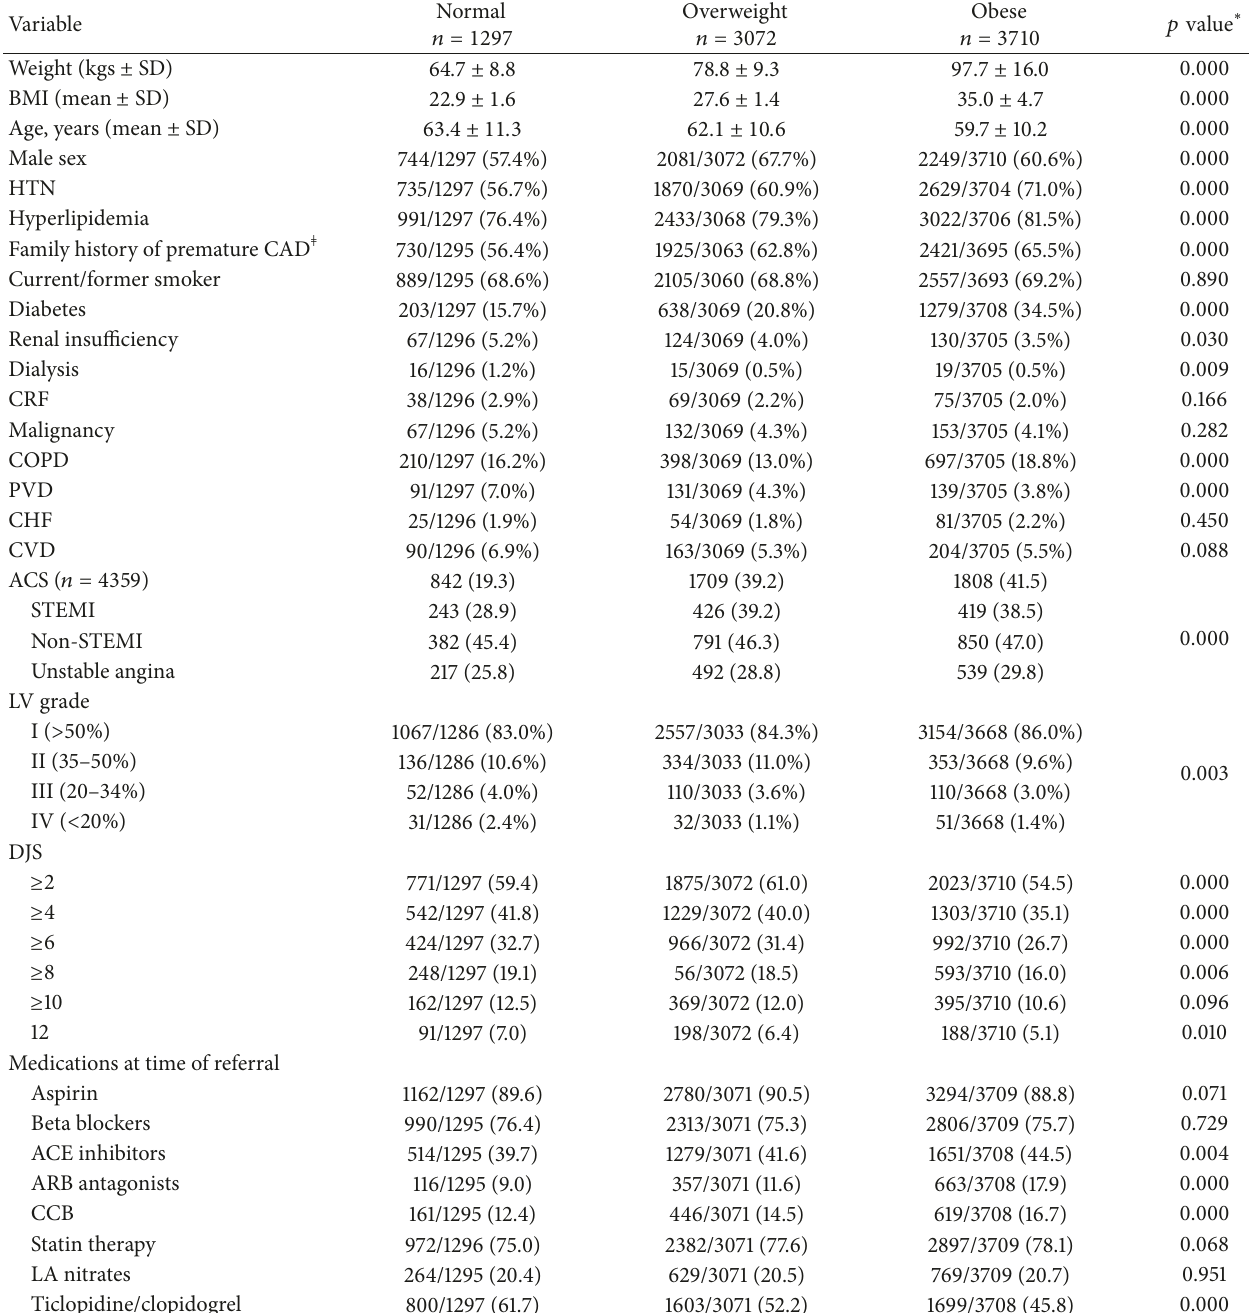
Table 1: Baseline characteristics of study subjects undergoing coronary angiography in relation to BMI category and Duke Jeopardy